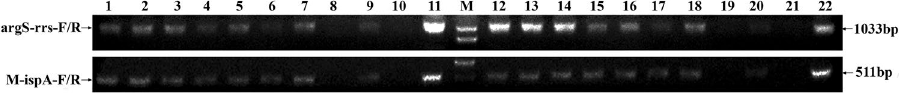
Figure 1. Elimination of Buchnera bacteria from aphids. 1–10: Fed on tetracycline-treated diet for 2, 2, 6, 6, 10, 10, 12, 12, 14 and 14 days before fed on non-antibiotic diet for 5, 10, 5, 10, 5, 10, 5, 10, 5 and 10 days, respectively; 12–21: Fed on rifampicin-treated diet for 2, 2, 6, 6, 10, 10, 12, 12, 14 and 14 days before fed on non- antibiotic diet for 5, 10, 5, 10, 5, 10, 5, 10, 5 and 10 days, respectively. PCR products were amplified by using the primers argS-rrs-F/R and M- ispA -F/R (cropped from Supplementary Figure S1). Marker: 1000/750 bp (upper); 750/500 bp (down).